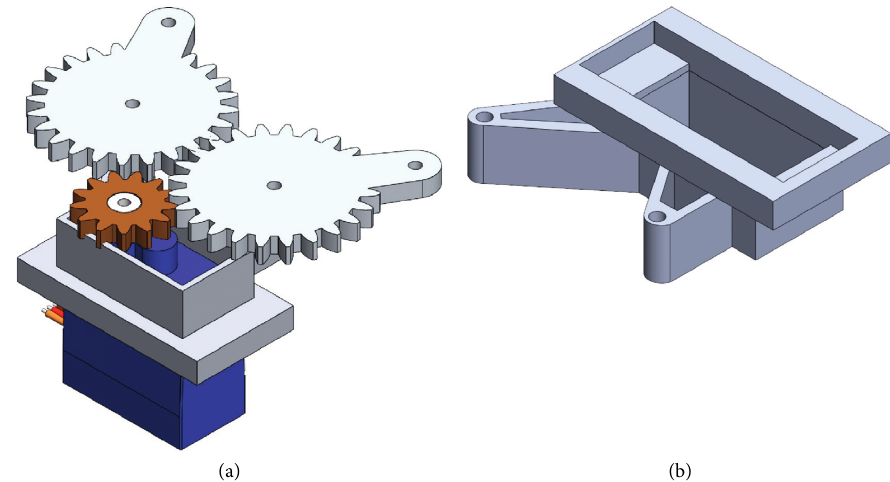
Figure 11: Gripper-like mechanism.